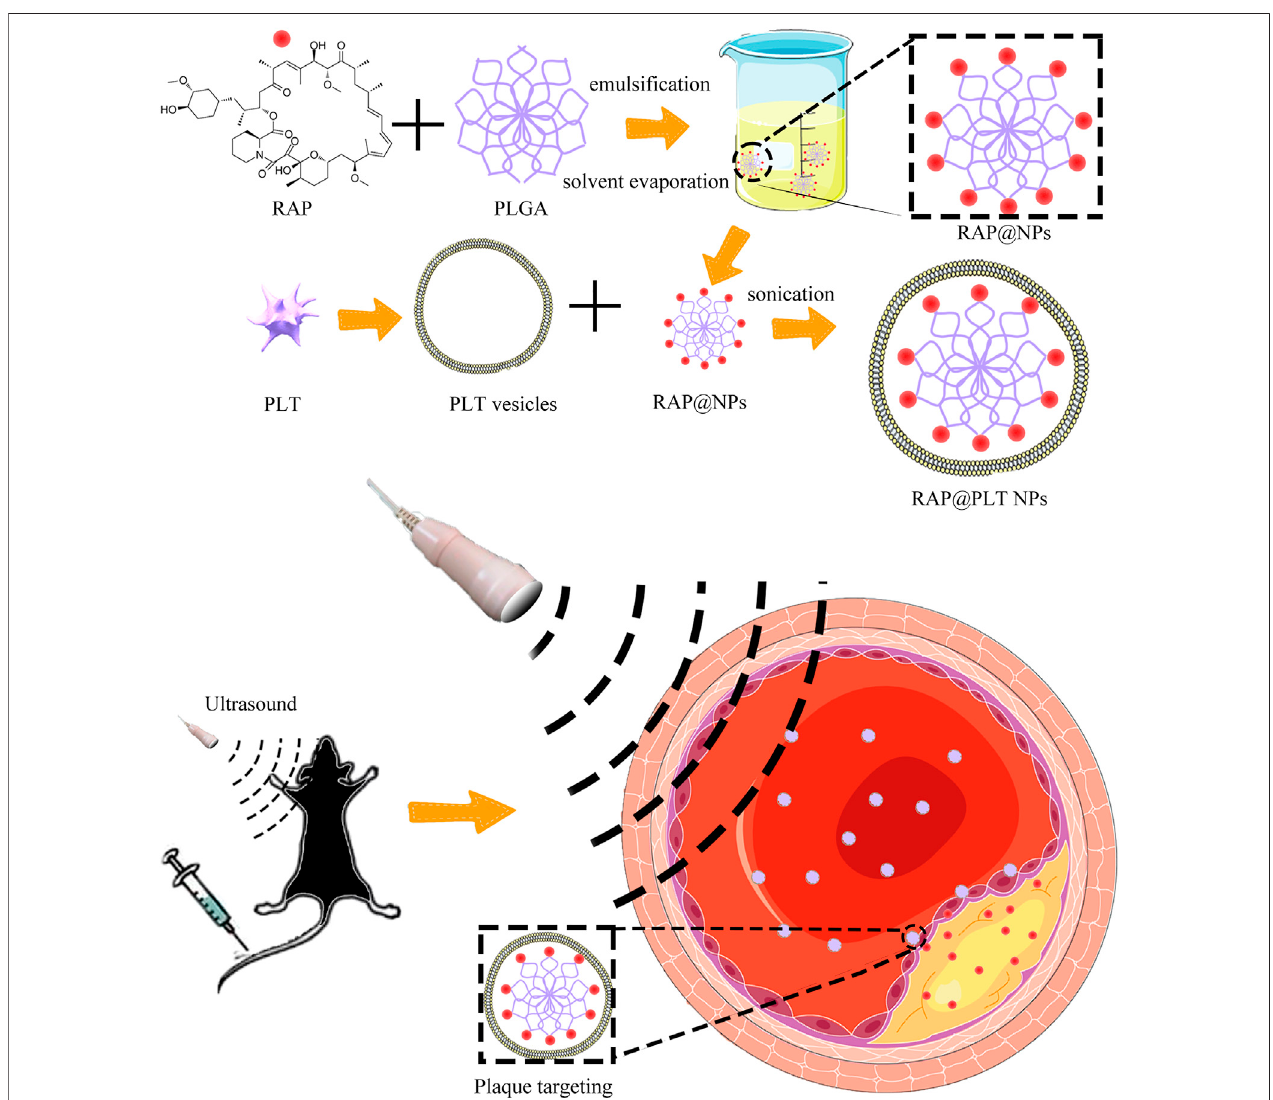
FIGURE 1 | The illustration of the preparation steps of RAP@PLT NPs and the working mechanism in vivo .